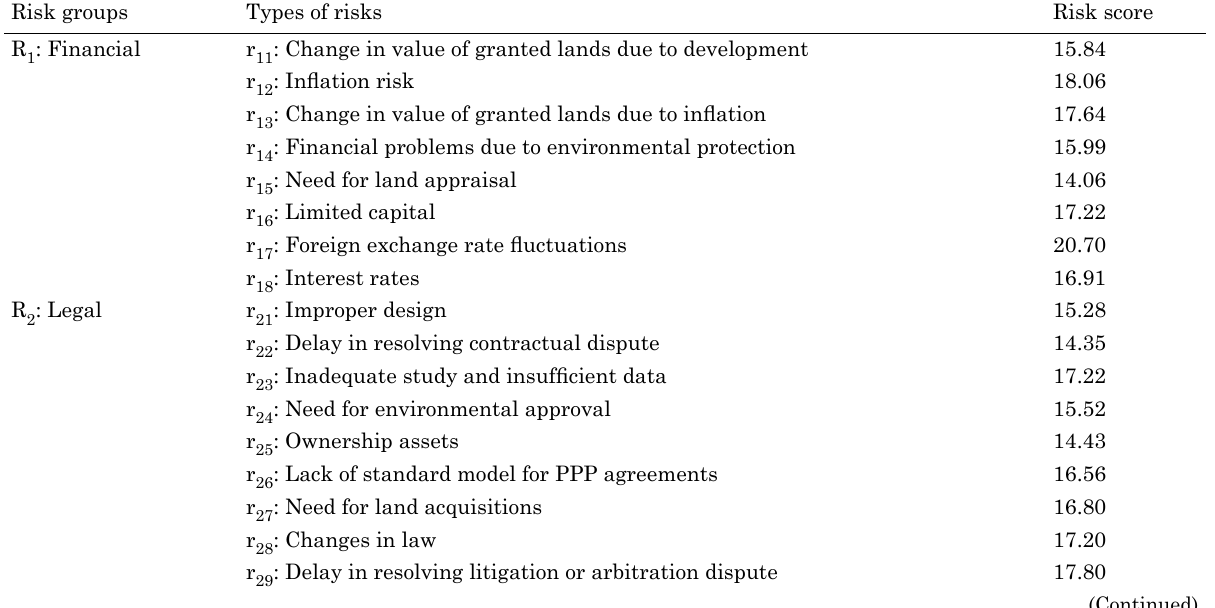
Table 4. Significant risks in Iranian PPP